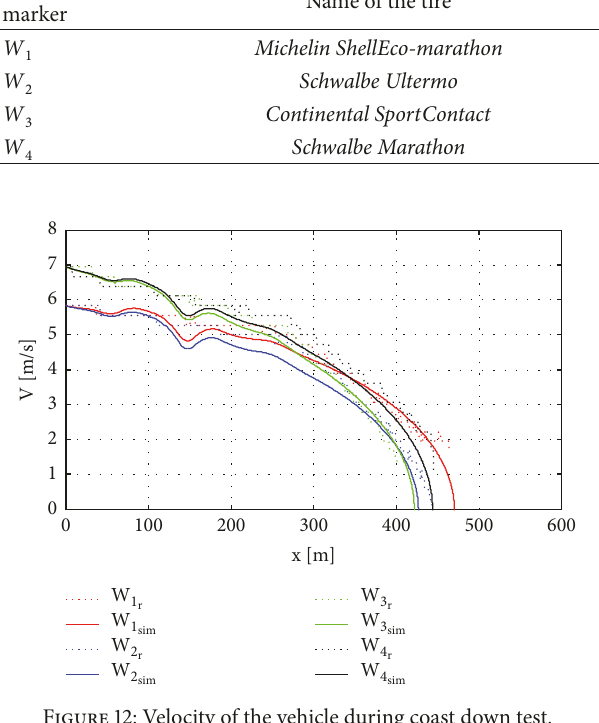
Figure 12: Velocity of the vehicle during coast down test.